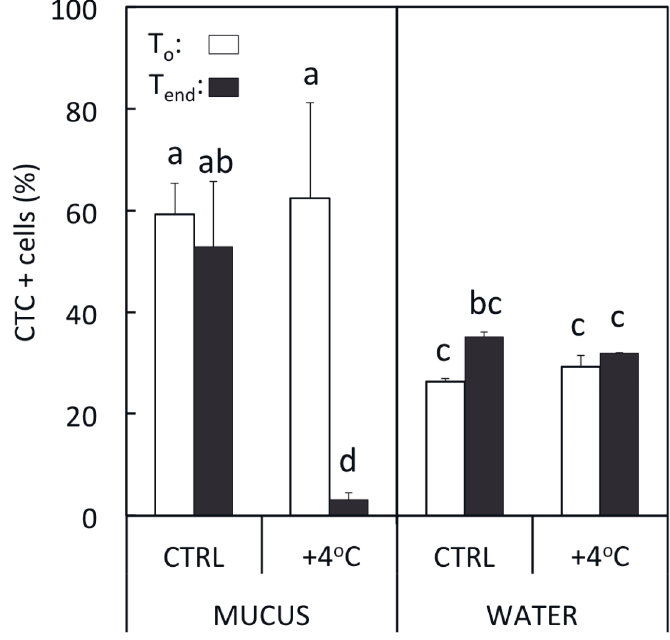
Figure 2. Percentages of CTC + cells in mucus samples of F. repanda in both control (CTRL) and heat-treatment (+4 °C). Error bars represent one standard deviation from the mean ( n = 3). Histograms with the same letters are not significantly different at p =